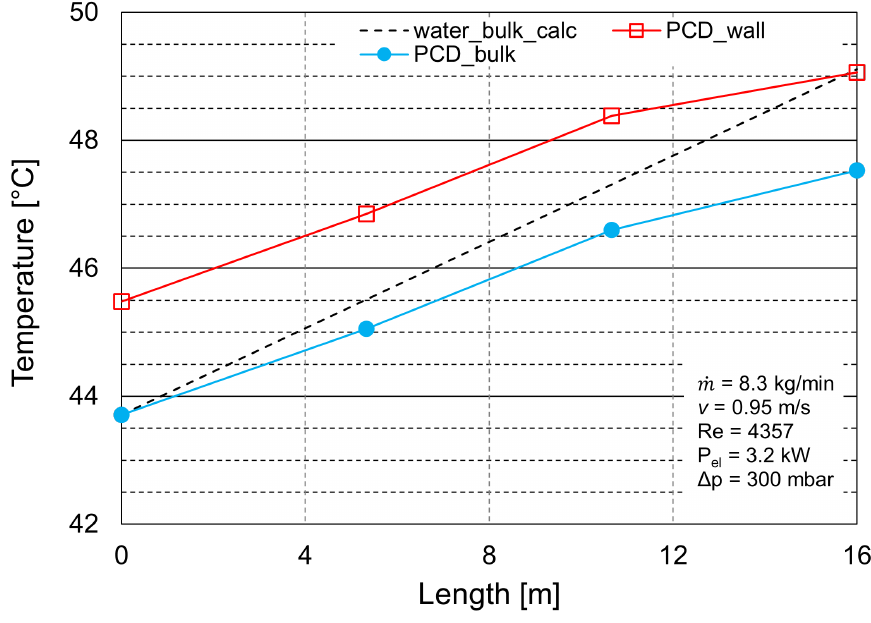
Figure 3. The evolution of the bulk and wall temperatures for the PCD for experiment 1 alongside the bulk temperatures calculated for water along the length of the